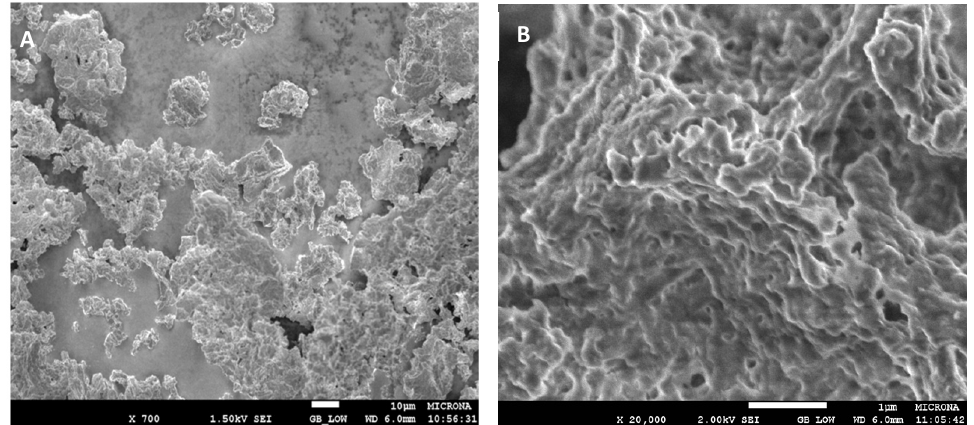
Figure 7. SEM Image of LipMatCCR11-CLEAs. ( A ) Magnification: 700×. ( B ) Magnification: 20,000×.